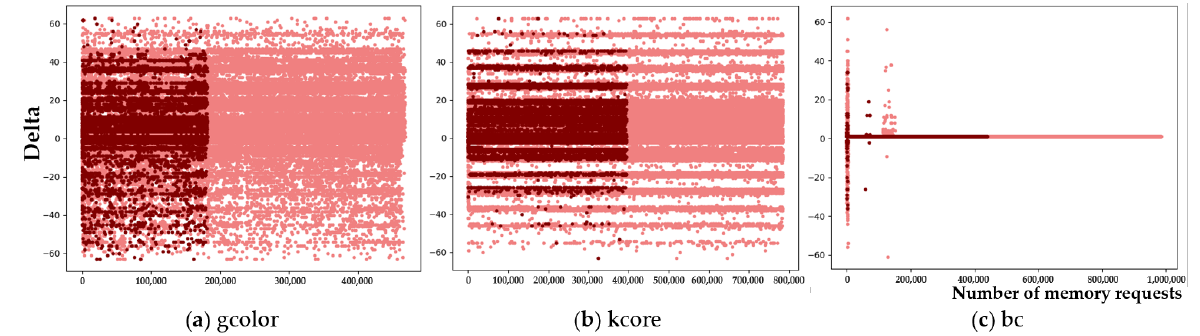
Figure 11. Coverage of module-S.